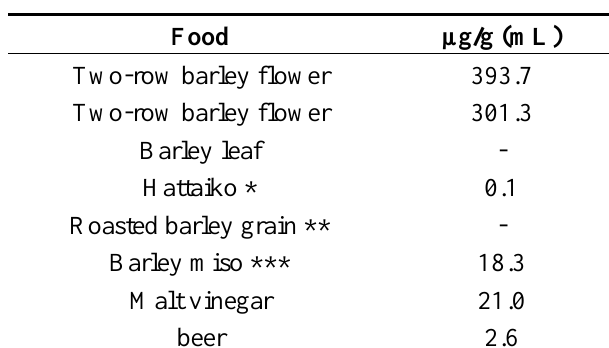
Table 2. Barley LTP